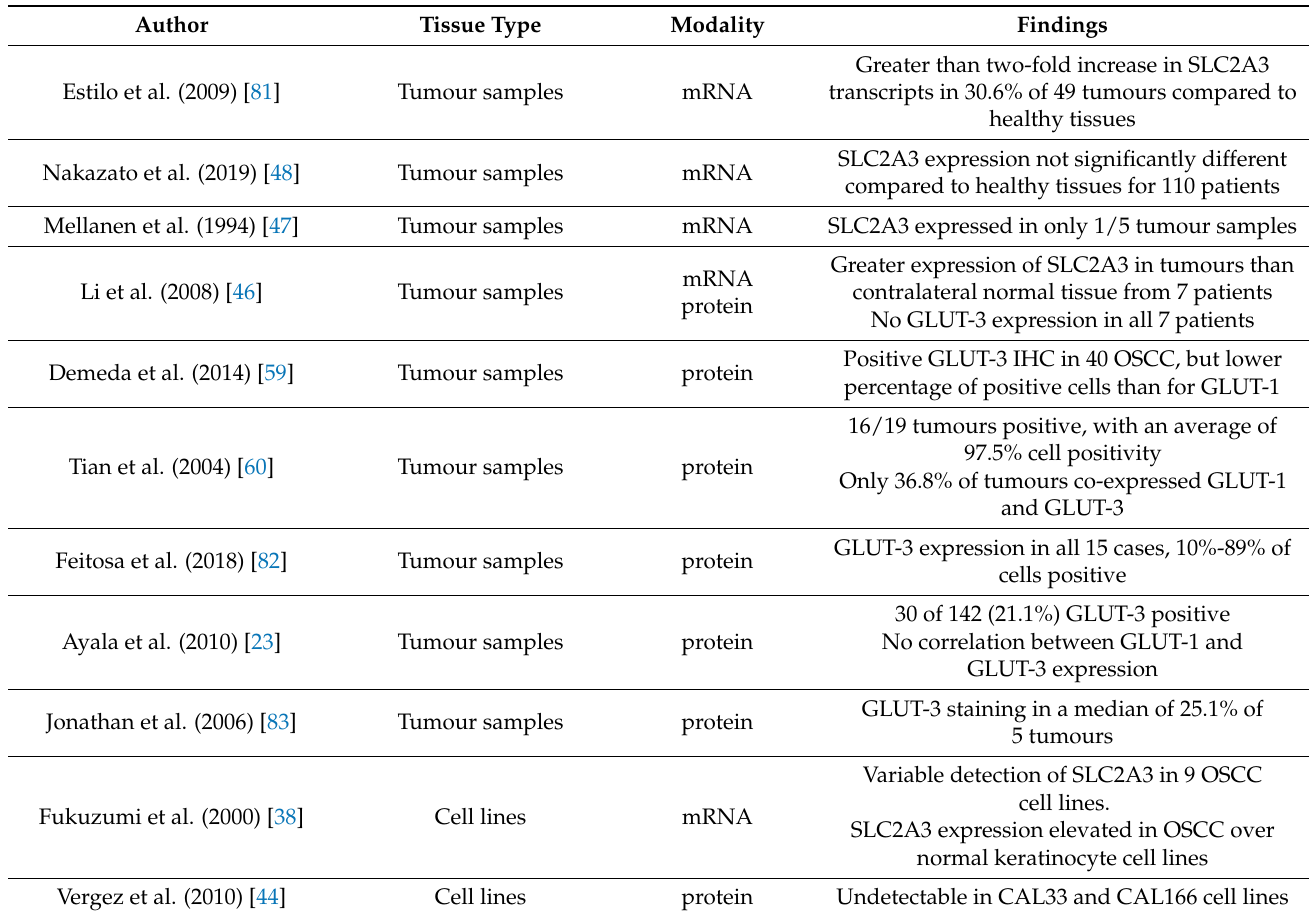
Figure 3. Proportion of patients with positive GLUT-1 expression in the 85 included studies according to immunohistochemical findings. Table 3. Summary of findings for